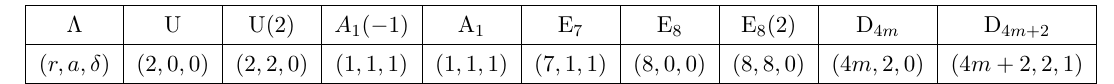
Table 4 . Even 2-elementary lattice building blocks for the construction of Γ K3 which are invariant under Nikulin’s